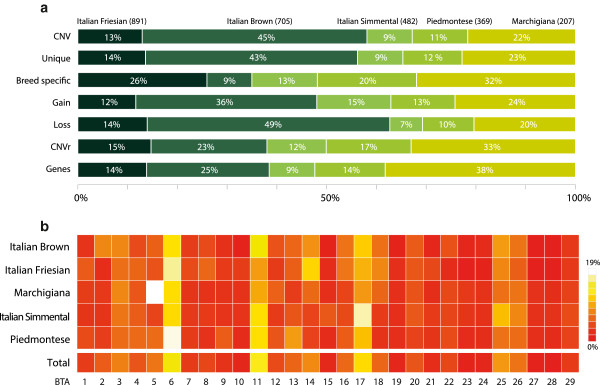
CNV breed profiles. a) Stacked bar chart showing the percentage of CNVs (total, unique, specific, gain and loss CNVs), CNVRs and number of genes affected for each breed studied with respect to each sample size. The number of samples for each breed is shown in parenthesis. b) Heatmap showing the CNV distribution in the 29 autosomal chromosomes. Dark red tiles represent low frequency CNVs, while pale yellow/white indicate high frequency CNVs.